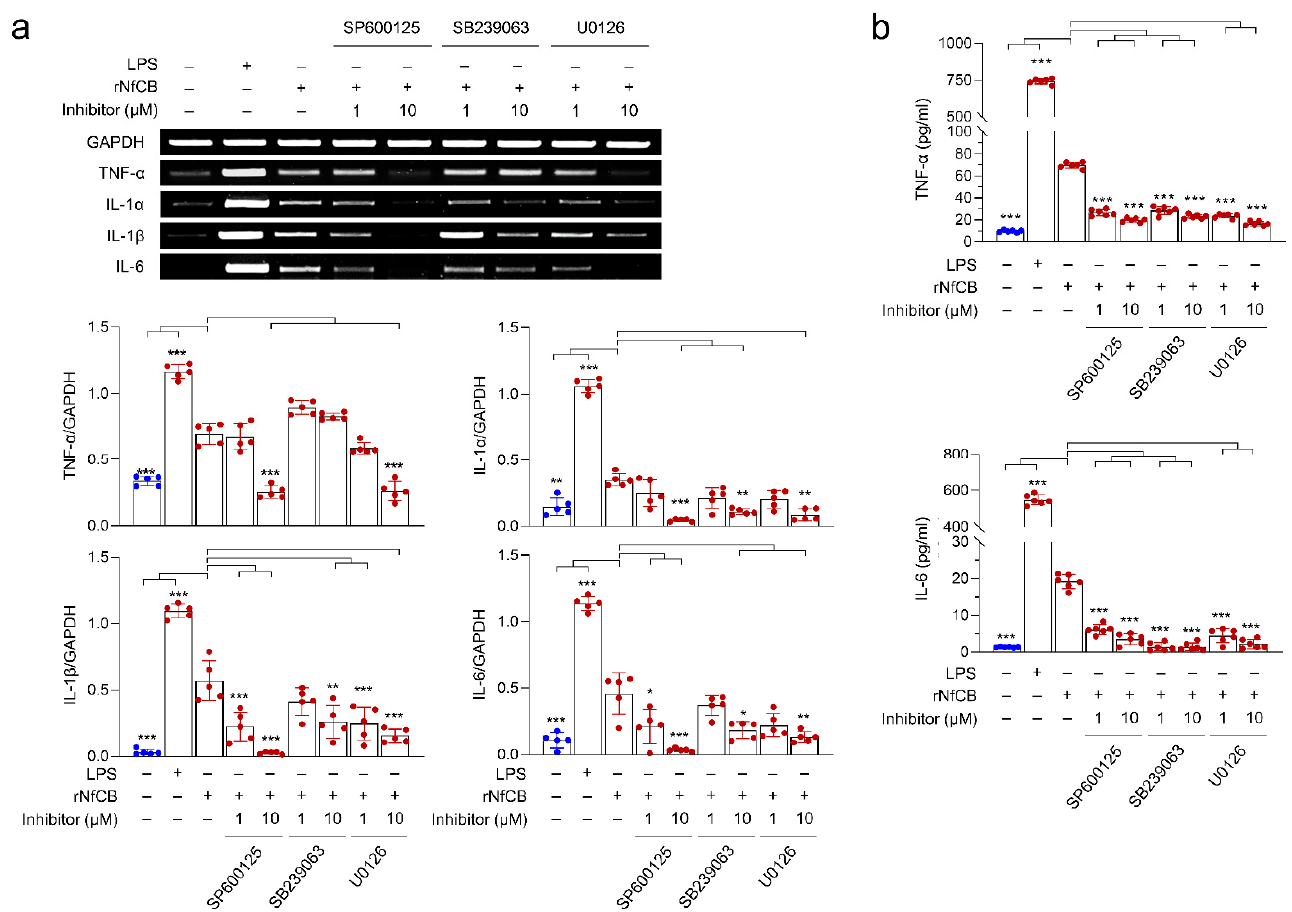
Figure 4. MAPK signaling pathways are involved in pro-inflammatory immune response of BV-2 microglial cells stimulated by rNfCB. ( a ) mRNA expression. BV-2 microglial cells were pre-treated with different concentrations (1 µM or 10 µM) of JNK inhibitor (SP600125), p38 inhibitor (SB239063), or ERK inhibitor (U0126) for 3 h. rNfCB (100 µg/mL) was then administered to the cells. The mRNA expressions of TNF- α , IL-1 α , IL-1 β , and IL-6 were analyzed via semi-quantitative RT-PCR. Bar graphs indicate the quantitative expression profile of each gene, represented as -fold induction of each gene relative to GAPDH in three independent experiments. ( b ) Quantitative ELISA. Production of TNF- α and IL-6 were measured using ELISA. Values are presented as mean ± SD of three independent experiments. One-way ANOVA with Dunnett’s post hoc test was performed as multiple comparisons with the control, treated with rNfCB. *** p < 0.0001, ** p < 0.001, * p < 0.01.